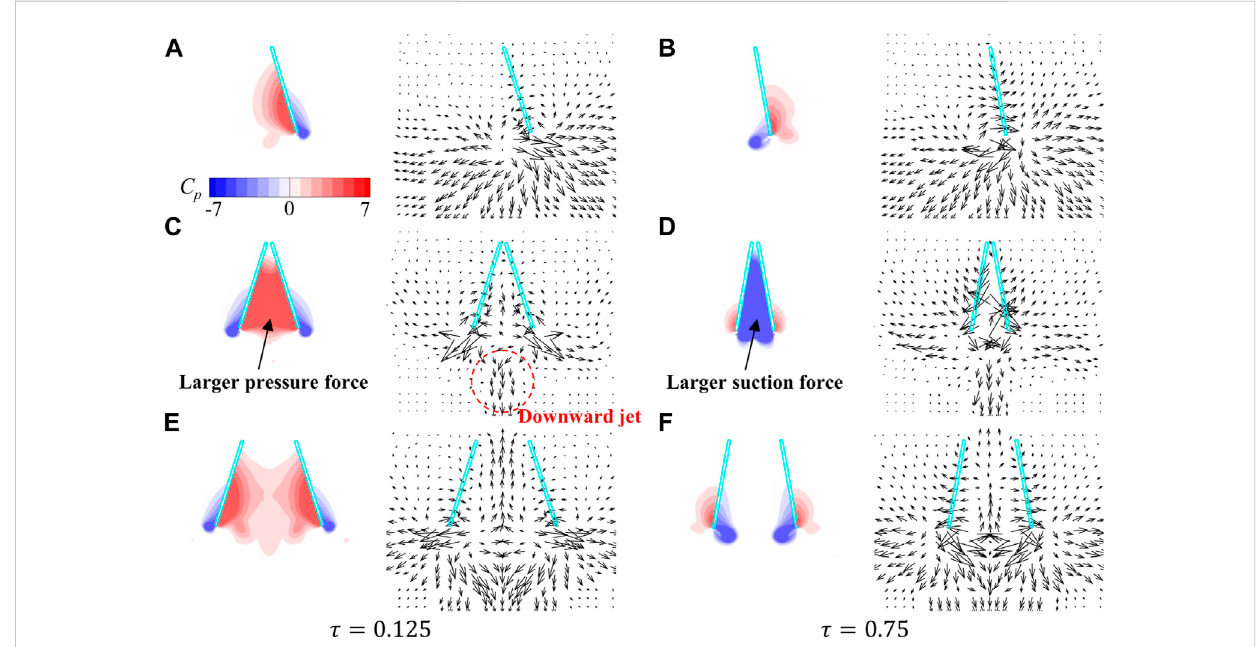
FIGURE 14 Pressure contours and the velocity vectors around the wings in the YOZ plane for the (A,B) single wing case, (C,D) H (cid:1) 0 . 1 c case, and (E,F) H (cid:1) 1 . 2 c case at τ (cid:1) 0 . 125 and τ (cid:1) 0 . 75. H is the distance between two wing roots.